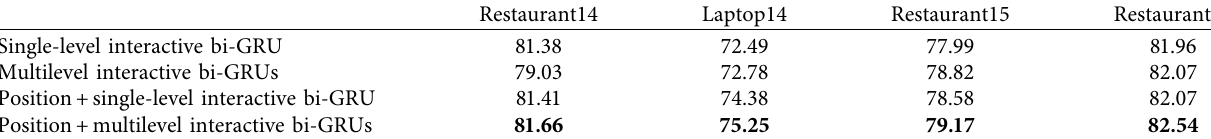
Table 5: Model accuracy of different technical combinations.